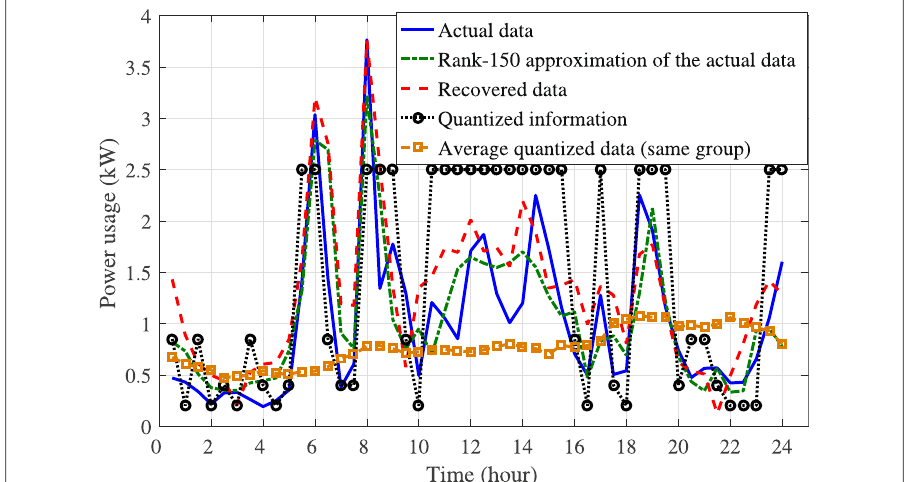
Fig. 5 Comparison of actual data, rank-150 approximation, recovered data, quantized data, and average quantized data in the same